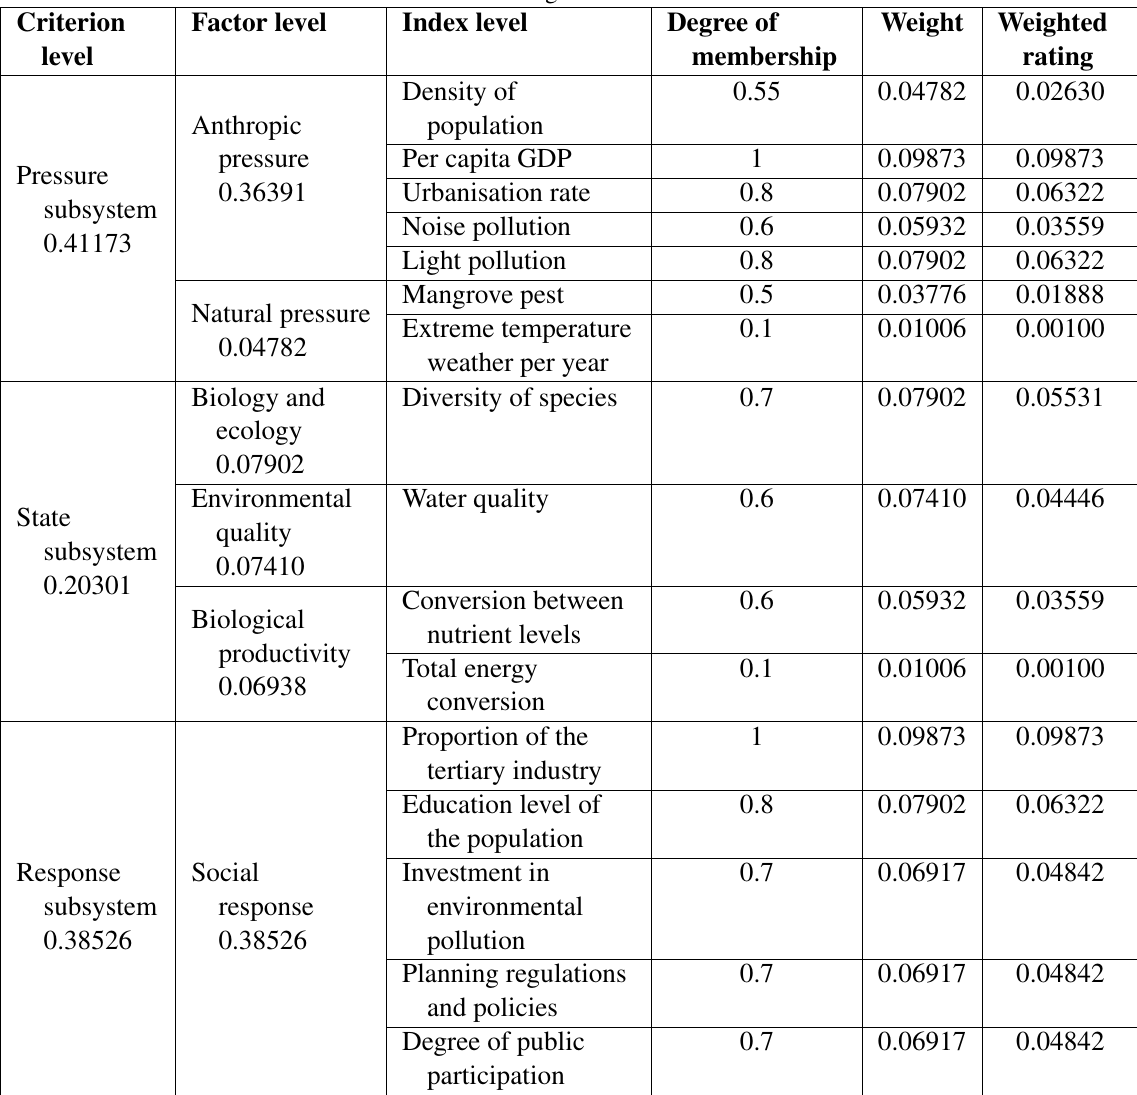
Table 9 Weight of each index.